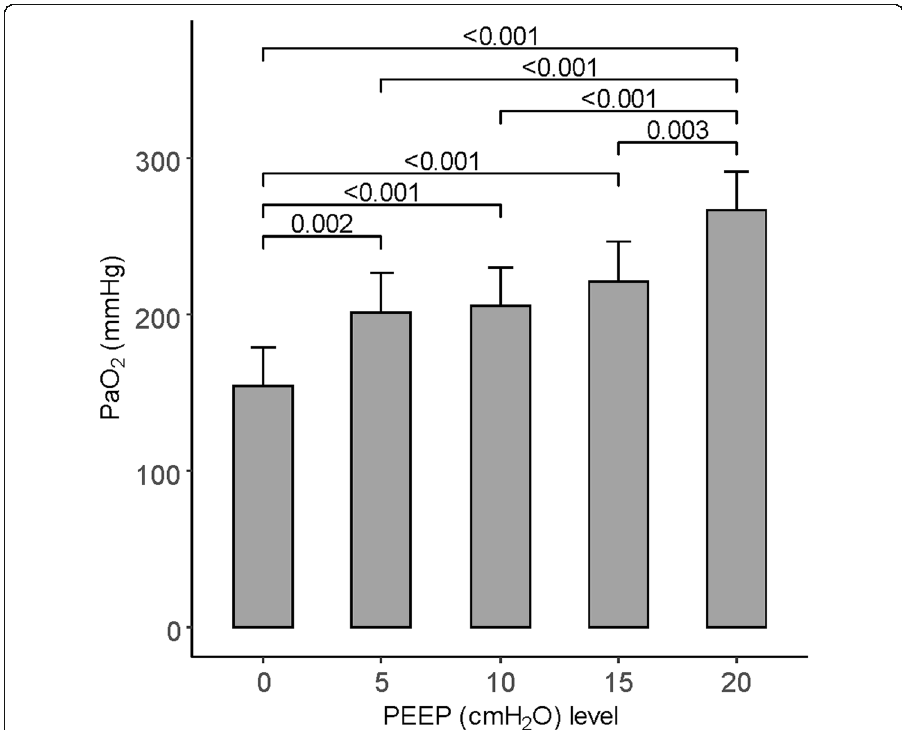
Fig. 3 Comparison of PaO 2 for the different positive end-expiratory pressure (PEEP) levels during cardiopulmonary